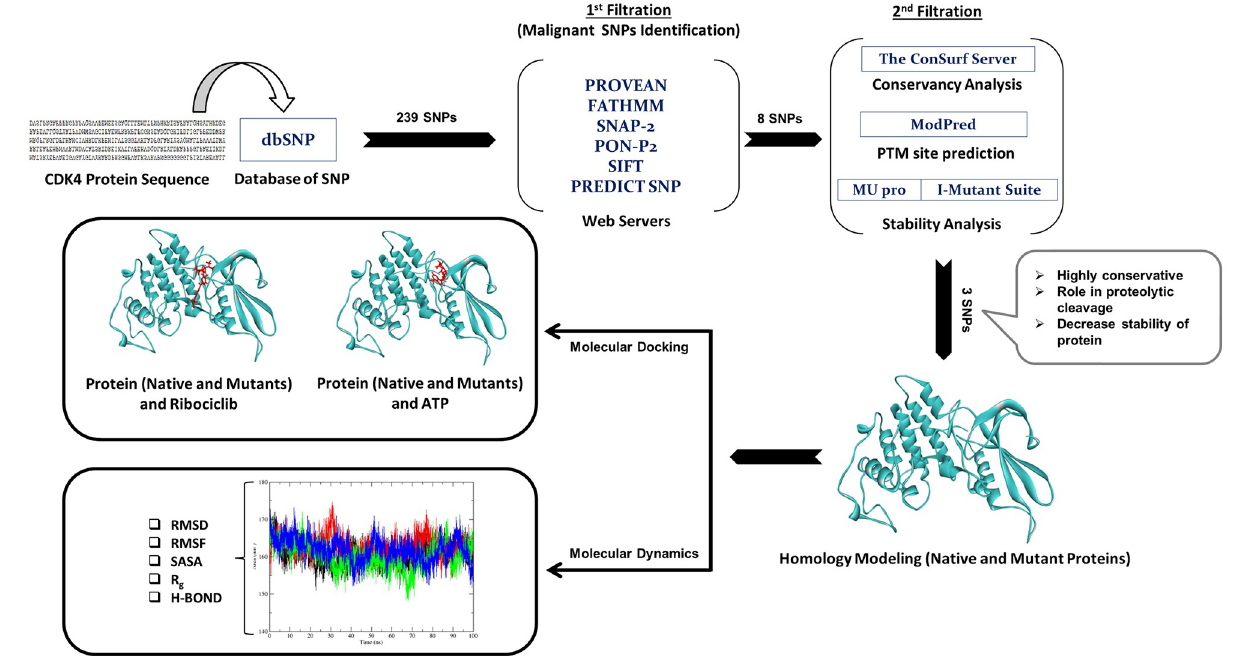
Fig 1. Flowchart for